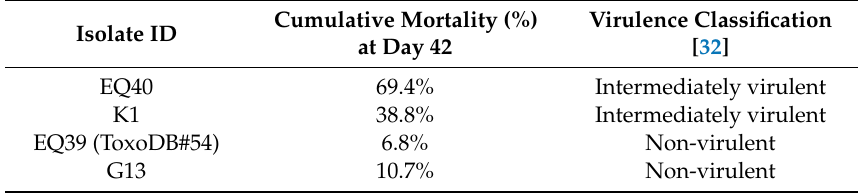
Table 2. Cumulative mortality and virulence